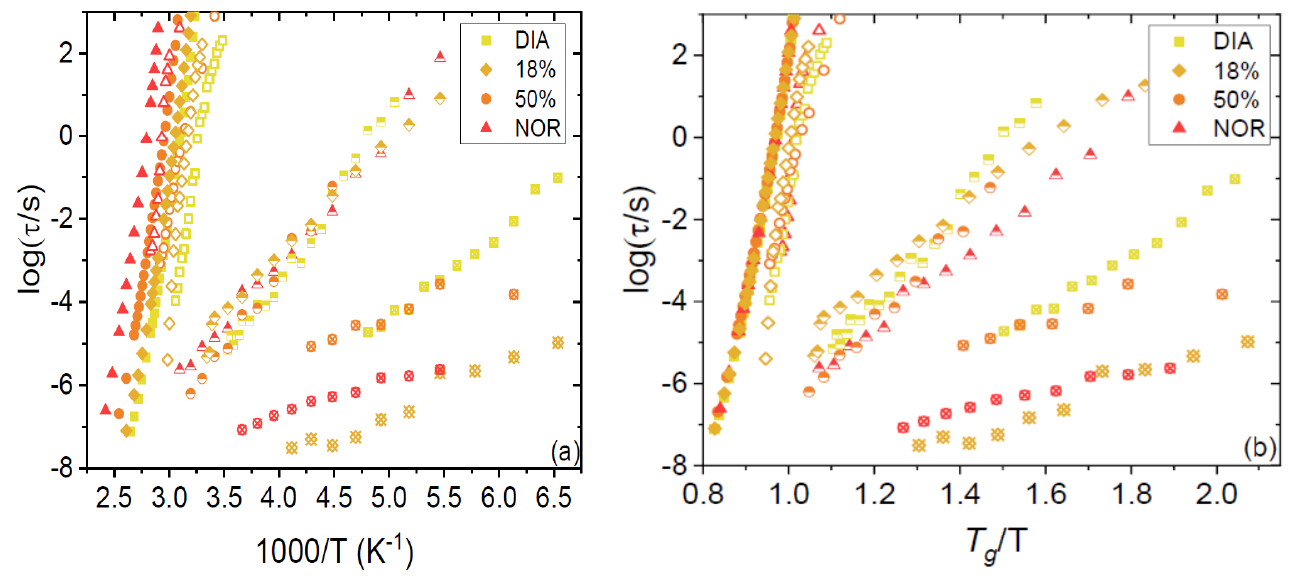
Figure 4. Relaxation times of DIA, NOR, and the 18% and 50 % binary mixtures (see legend) plotted against the reciprocal of the temperature (Arrhenius plot, ( a )) and of the reduced temperature T / T g (Angell plot, ( b )). All relaxations are shown: α (solid points), β (open points), γ (half points), and γ’ (crossed points).